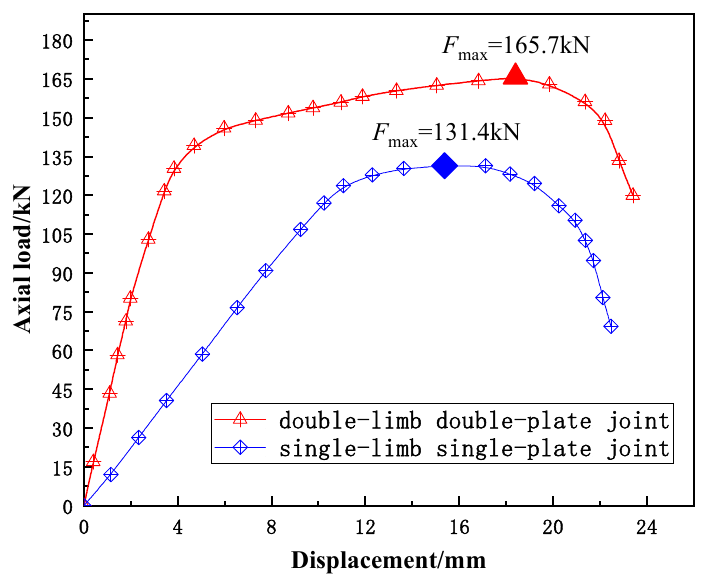
Figure 9. Load-displacement curve of joint specimen.